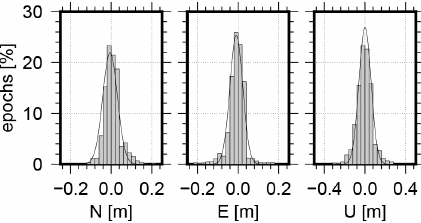
Figure 4. Histogram of coordinate variations in the north, east and up directions for the dry dock period of RV Polarstern (7 July to 3 August 2019); a mean coordinate was subtracted; please note the different scales for horizontal and vertical components.